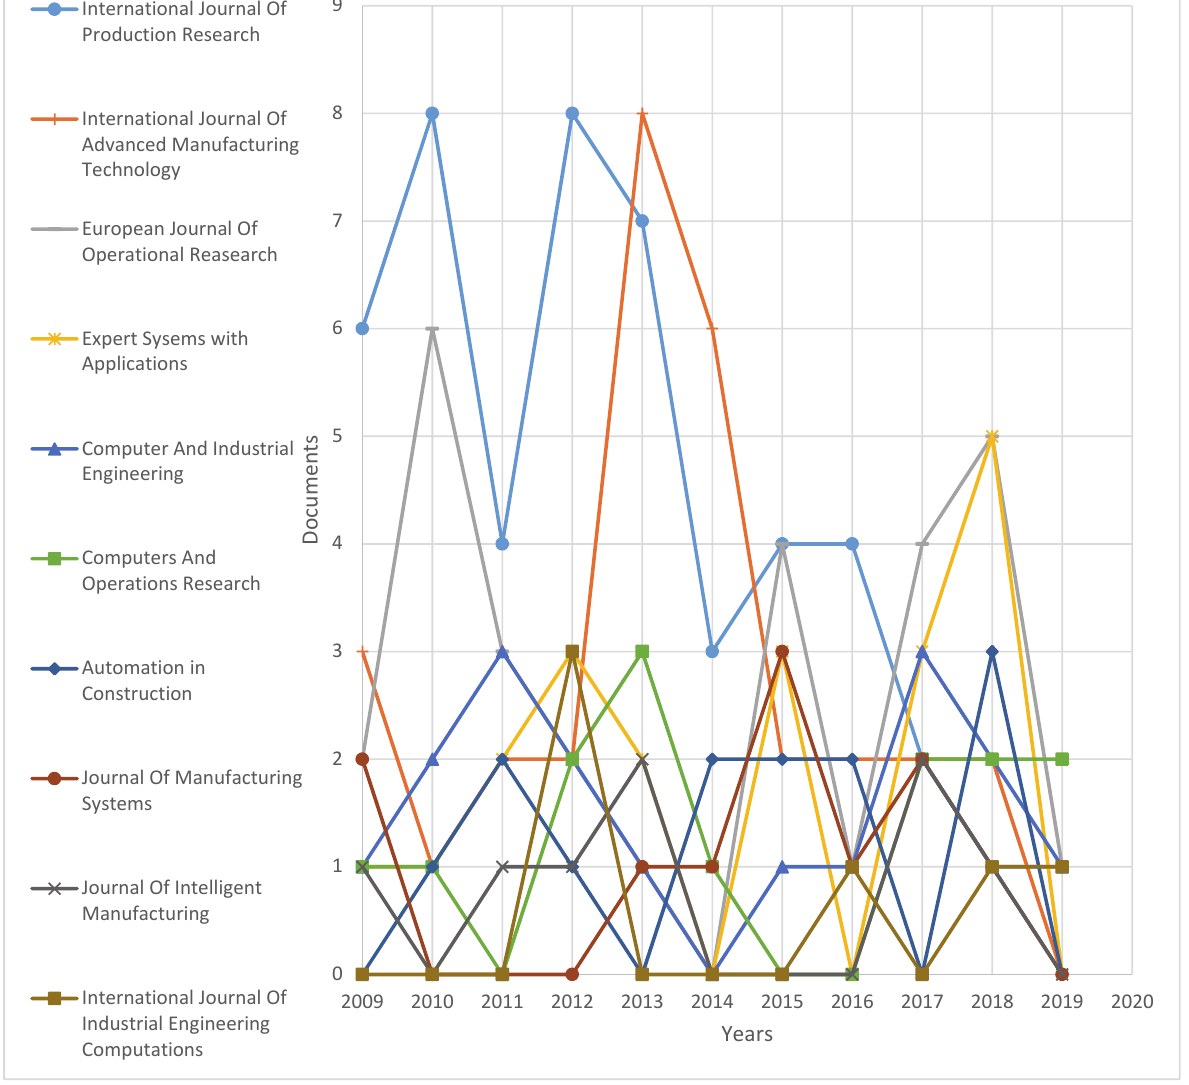
Fig. 8. Documents per year by source